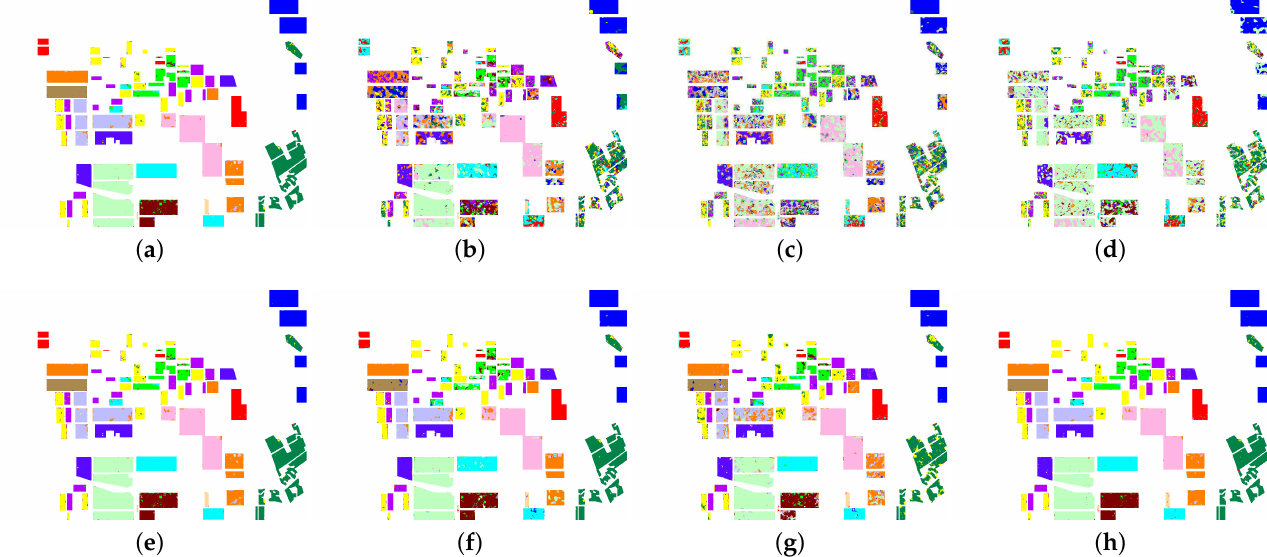
Figure 3. Classification result of the ground-truth map of Flevoland image obtained by four classifiers on different forms of Touzi decomposition parameters, including ( a ) SVM on original parameters, ( b ) ANN on original parameters, ( c ) autoencoder (AE) on original parameters, ( d ) classifier based on AE (AEFT) on original parameters, ( e ) SVM on normalized parameters, ( f ) ANN on normalized parameters, ( g ) AE on normalized parameters, and ( h ) AEFT on normalized